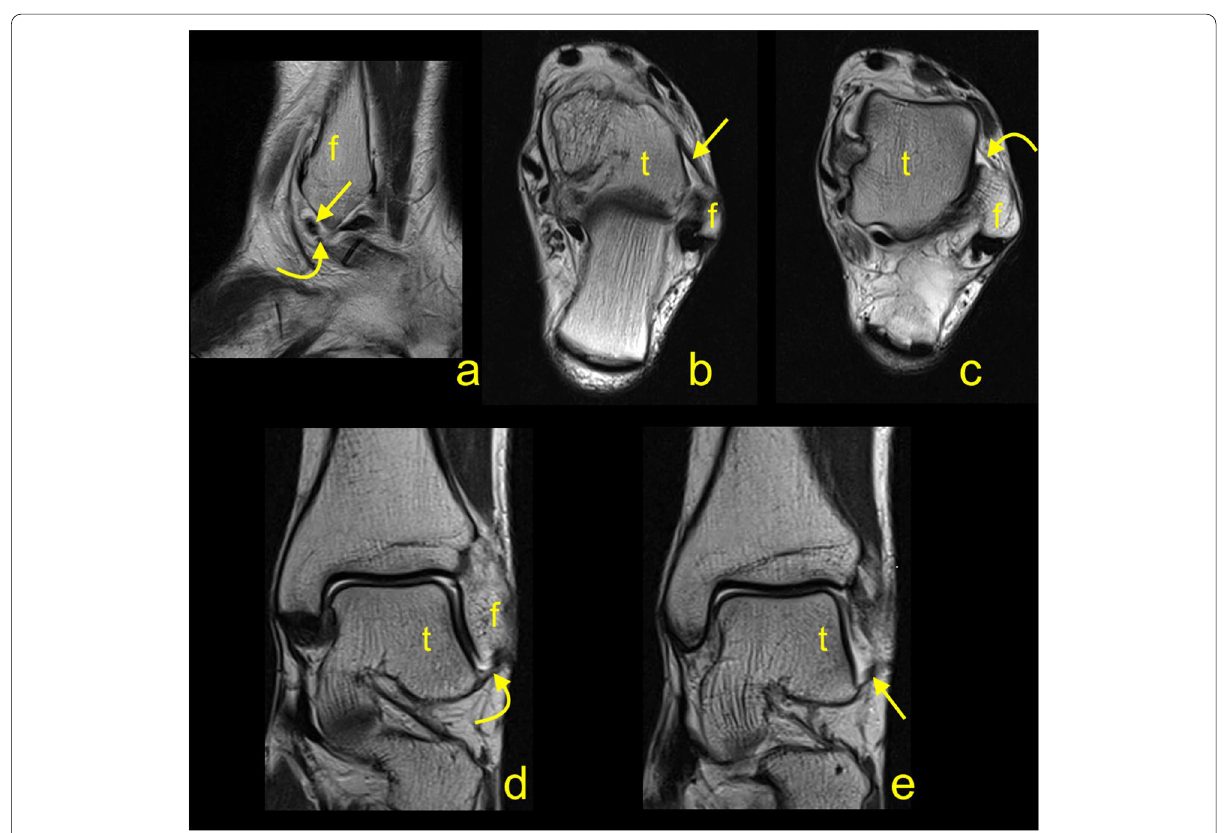
Fig. 5 A double fascicular anterior talofibular ligament. Two symmetrical fascicles are visible: a superior fascicle (arrow) and an inferior fascicle (curved arrow). The dashed arrow shows the midportion of the CFL. A T2-weighted axial section; b T2-weighted coronal section; c T2-weighted sagittal section. F, fibula; t,